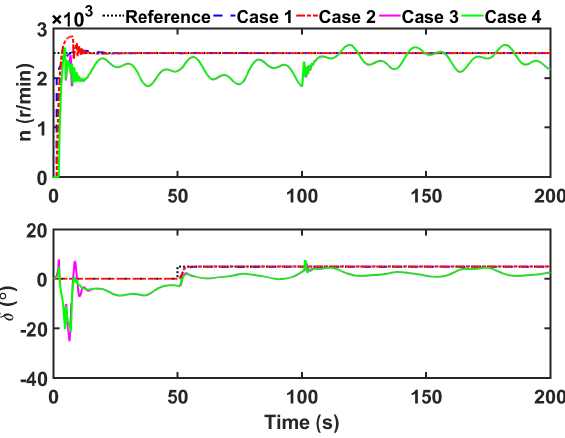
Figure 10. The trajectory tracking control